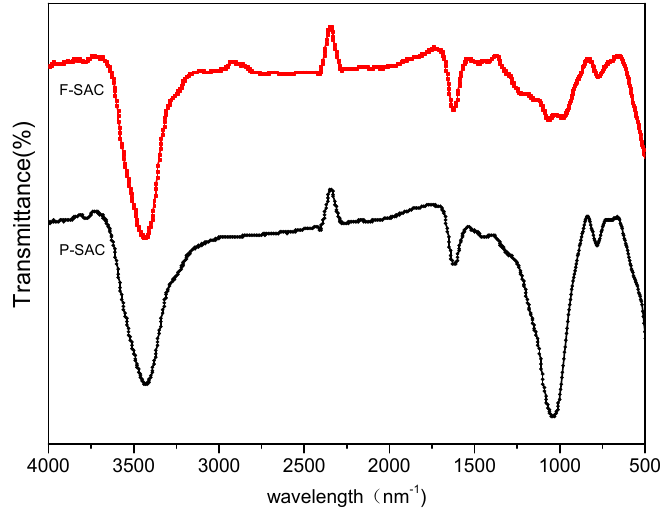
Figure 3. Fourier transform-infrared (FT-IR) spectra of F-SAC and P-SAC.